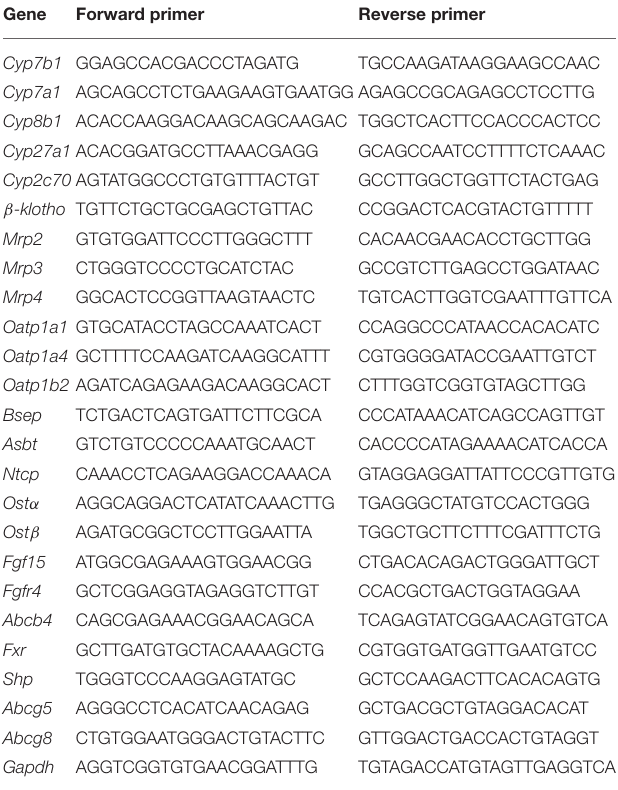
TABLE 1 | Primer sequences for quantitative real-time PCR analysis.